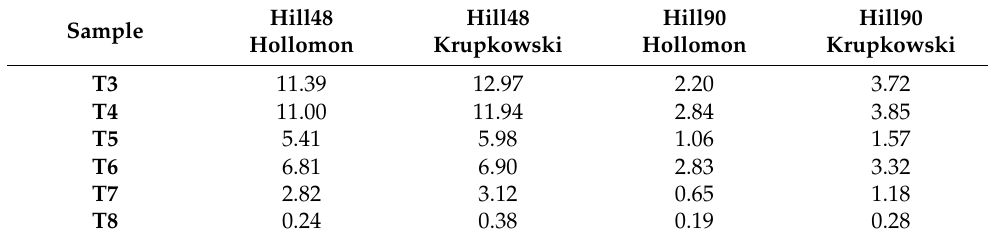
Table 5. The mean deviations (%) of predicted thickness values from the experimental thickness values using software with the explicit solver.